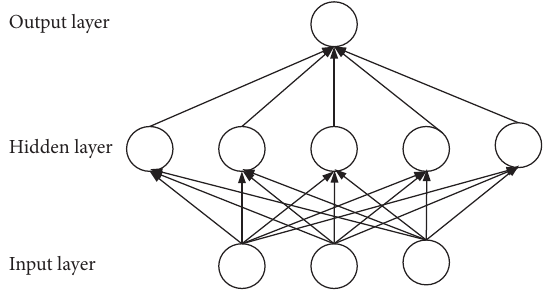
Figure 7: A simple ANN